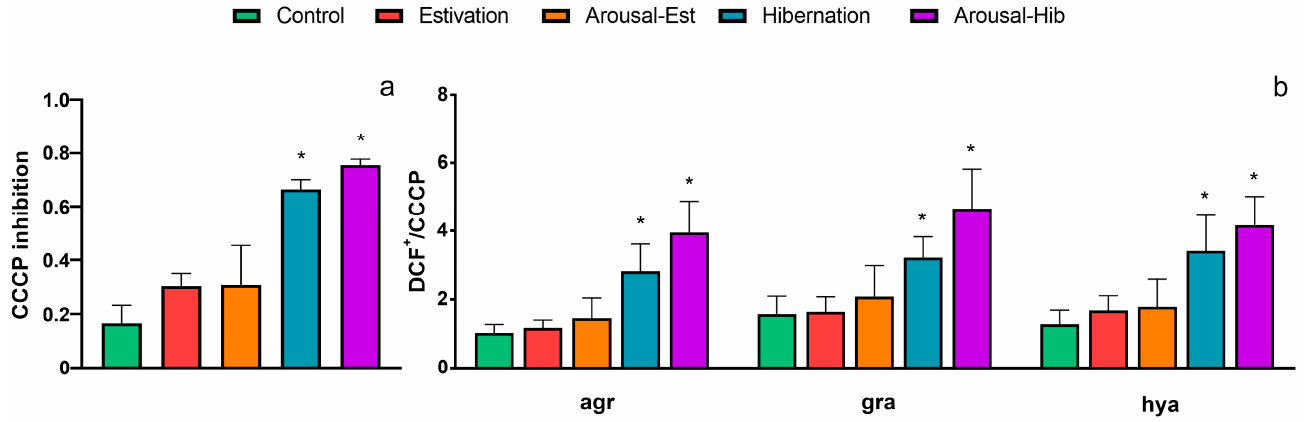
Figure 4. Inhibition of ROS production by CCCP. ( a ) Inhibition ratio for total hemocytes; ( b ) inhibition ratio for separate hemocyte subpopulations. Abbreviations: agr, agranulocytes; gra, granulocytes; hya, hyalinocytes. Asterisks (*) indicate significant differences with the control group ( p < 0.05, Kruskal-Wallis, Dunn’s